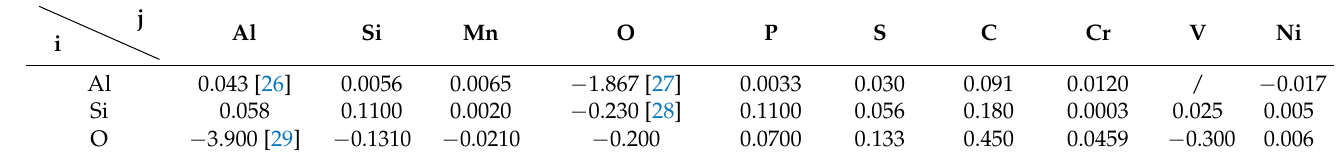
Table 8. Interaction coefficients of elements in molten steel at 1873 K